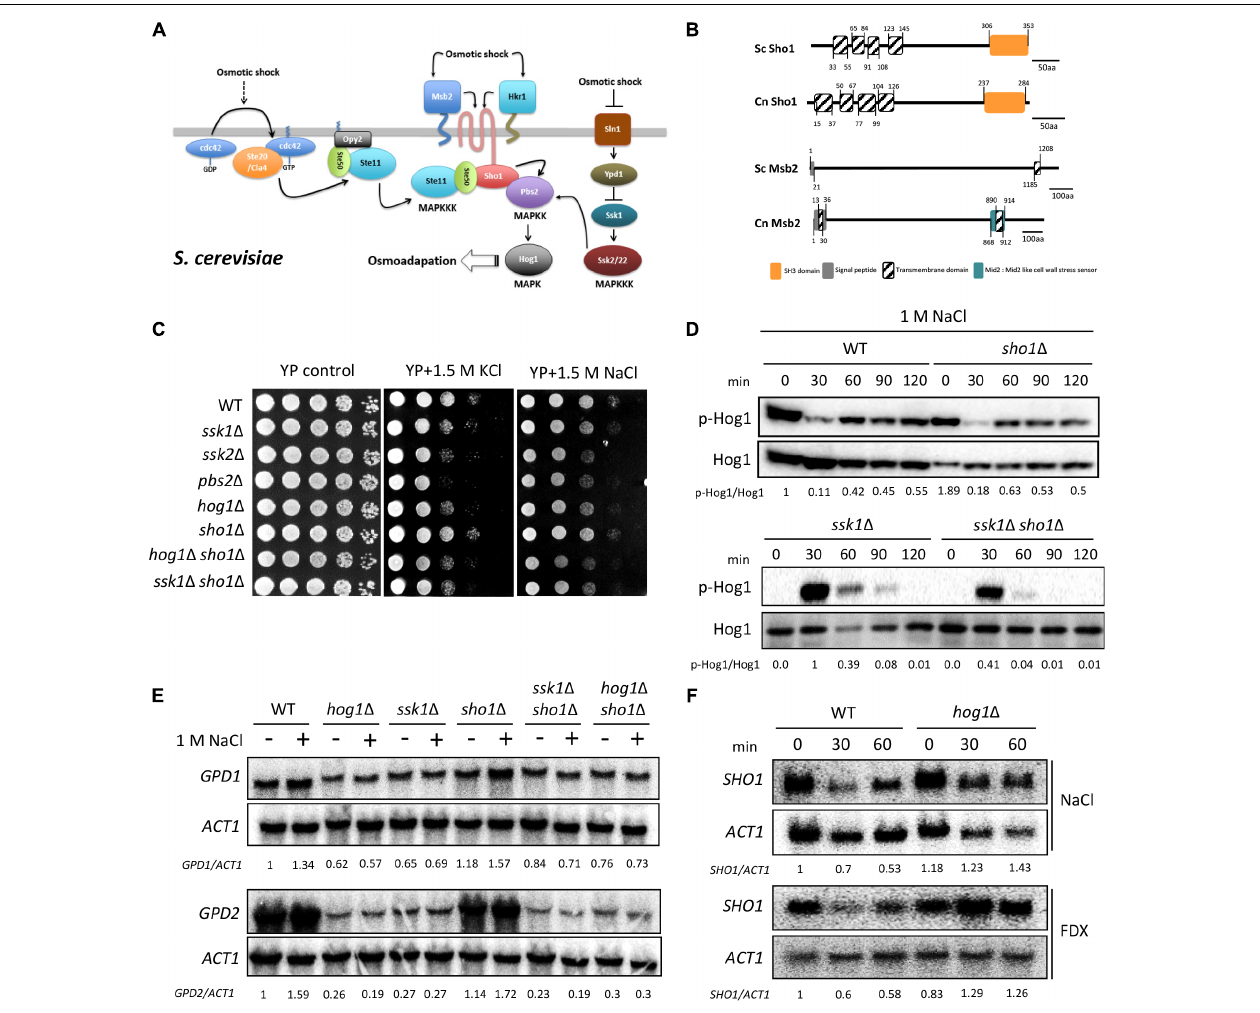
FIGURE 1 | Sho1 regulates the osmotic stress response in Hog1-independent manner. (A) Sho1 and Sln1 branches of the HOG pathway induced by the hyperosmolarity in Saccharomyces cerevisiae . (B) The domain structure of Sho1 and Msb2 proteins in C. neoformans and S. cerevisiae . The protein domains were analyzed using the Pfam protein domain analysis (http://pfam.xfam.org). The SH3 domain, signal peptide, transmembrane domains, and Mid2 domain are marked. (C) Wild-type (WT; H99), ssk1 (cid:49) (YSB261), ssk2 (cid:49) (YSB264), pbs2 (cid:49) (YSB123), hog1 (cid:49) (YSB64), sho1 (cid:49) (YSB1719), hog1 (cid:49) sho1 (cid:49) (YSB2268), and ssk1 (cid:49) sho1 (cid:49) (YSB2253) strains were grown overnight at 30 ◦ C in the liquid yeast extract–peptone–dextrose (YPD) medium. The strains were 10-fold serially diluted (1–10 4 dilutions) and spotted on the YP medium containing the 1.5-M concentration of NaCl or KCl. This spot assay was repeated more than three times and one representative image was shown here. (D) Strains were grown to the mid-logarithmic phase and exposed to 1-M NaCl for the indicated times. Total protein extracts were prepared for the western blot analysis. Hog1 phosphorylation levels were monitored using anti-P-p38 antibody. The blot was stripped and used for detection of Hog1 with a polyclonal anti-Hog1 antibody as a loading control. These western blot analyses were repeated twice and one representative result was shown here. (E,F) Each strain grown to the mid-logarithmic phase was further incubated in YPD medium containing 1-M NaCl for 30 min (E) or YPD medium containing 1-M NaCl or 2- µ g/mL fludioxonil (FDX) for the indicated time (F) . Total RNAs were prepared for the northern blot analysis. Each membrane was hybridized with the gene-specific probe. The relative expression levels of GPD1 , GPD2 , and SHO1 were quantitatively measured using a PhosphorImager after normalization with ACT1 expression levels. These northern blot analyses were repeated twice and one representative result was shown